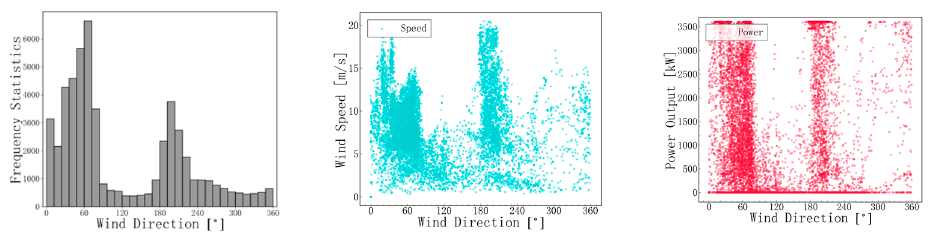
Figure 9. Diagram of wind distribution and wind speed and power output corresponding to wind direction.